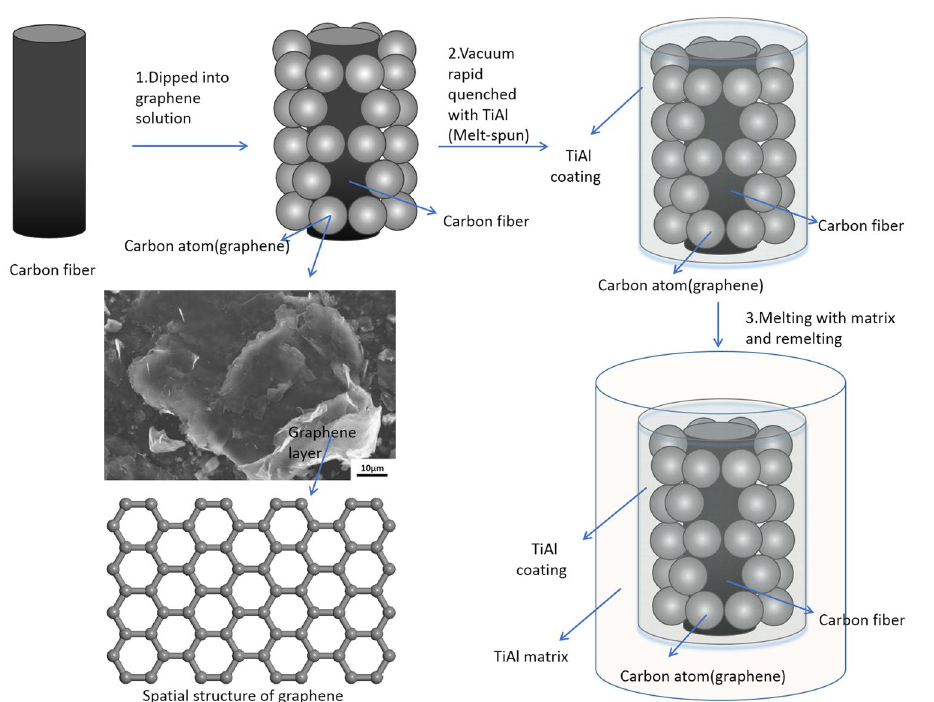
Figure 8. The technical processes and model of